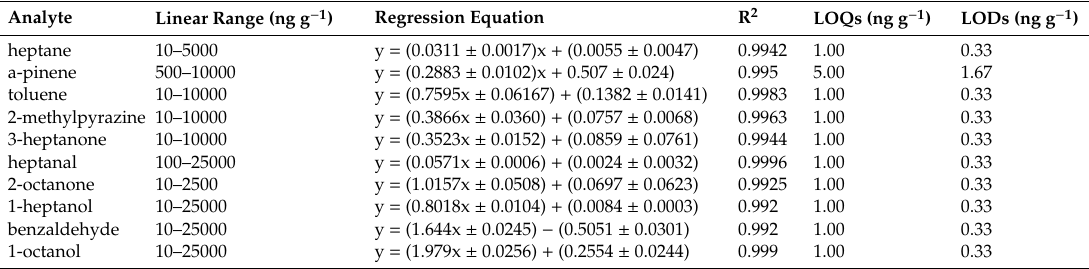
Table 1. Regression equations, linear range, Limits of Detection (LOD) and Limits of Quantification (LOQ) values for the target analytes.